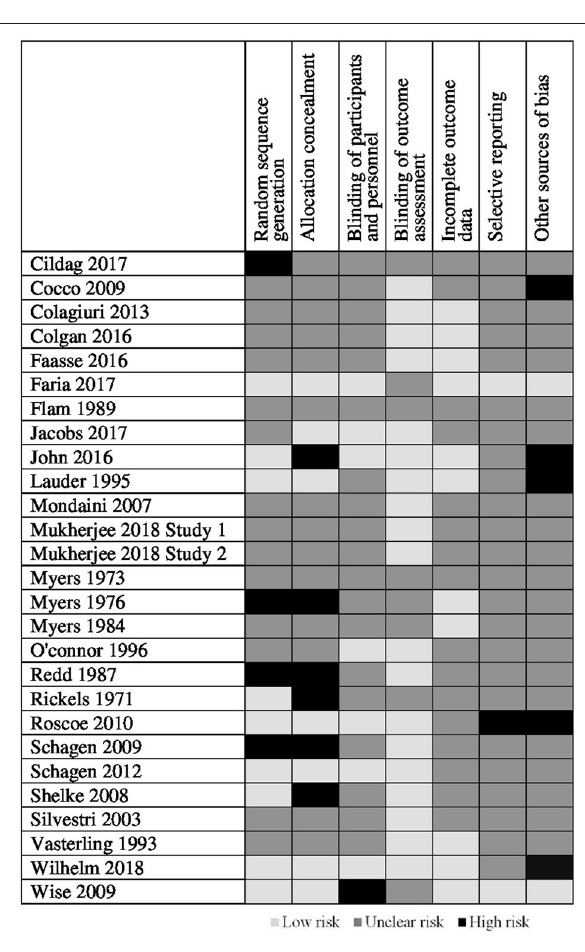
Table 2 ). Colagiuri et al. (26) found a slight trend for priming patients by assessing their expectancies for side-effects